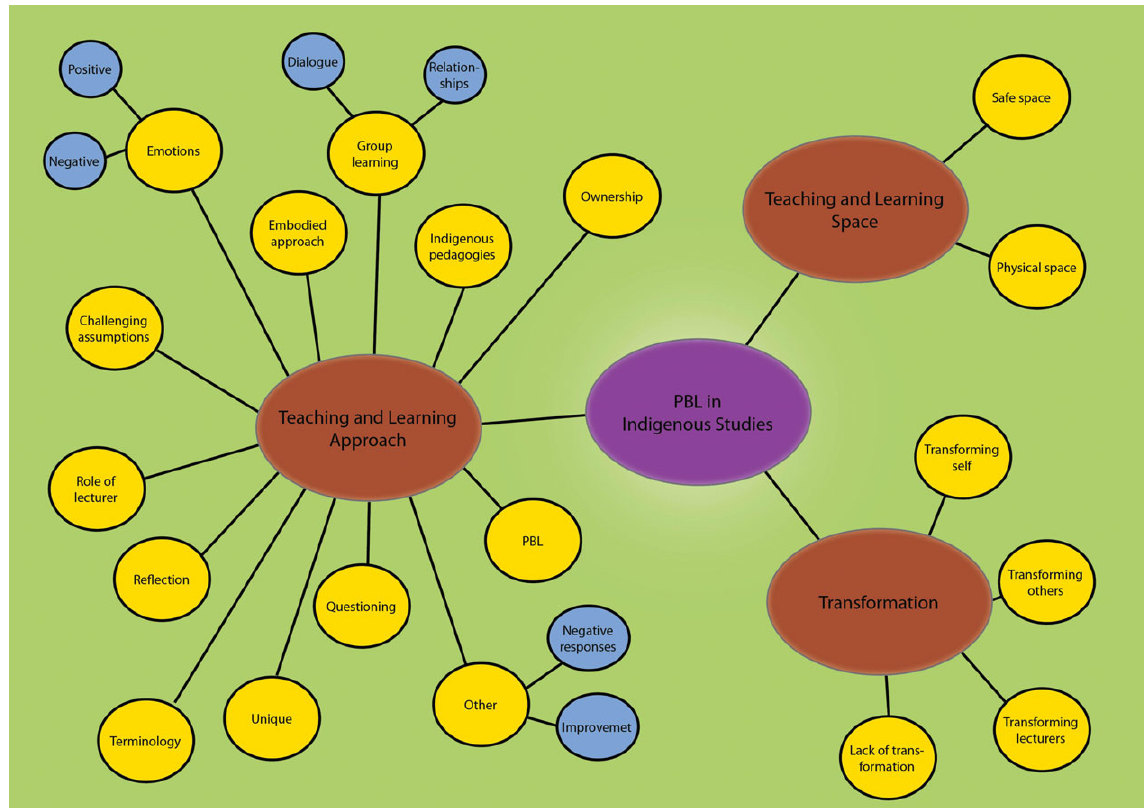
(Colour online) Themes in the